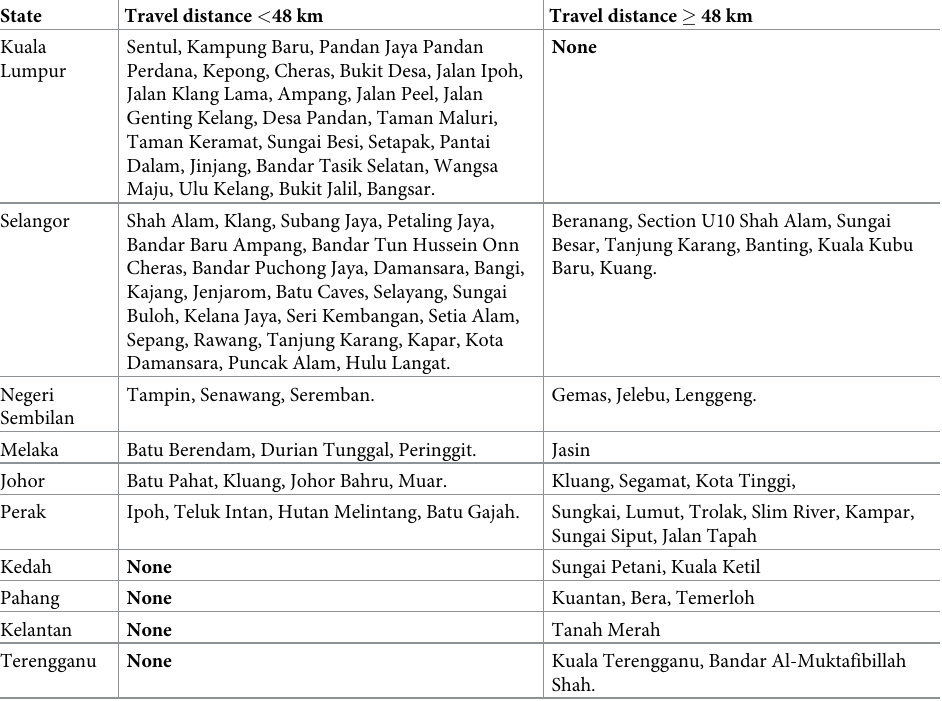
Table 7. Locations of respondents who had travel distance of 48 km and more. State Travel distance < 48 km Travel distance (cid:21) 48 km